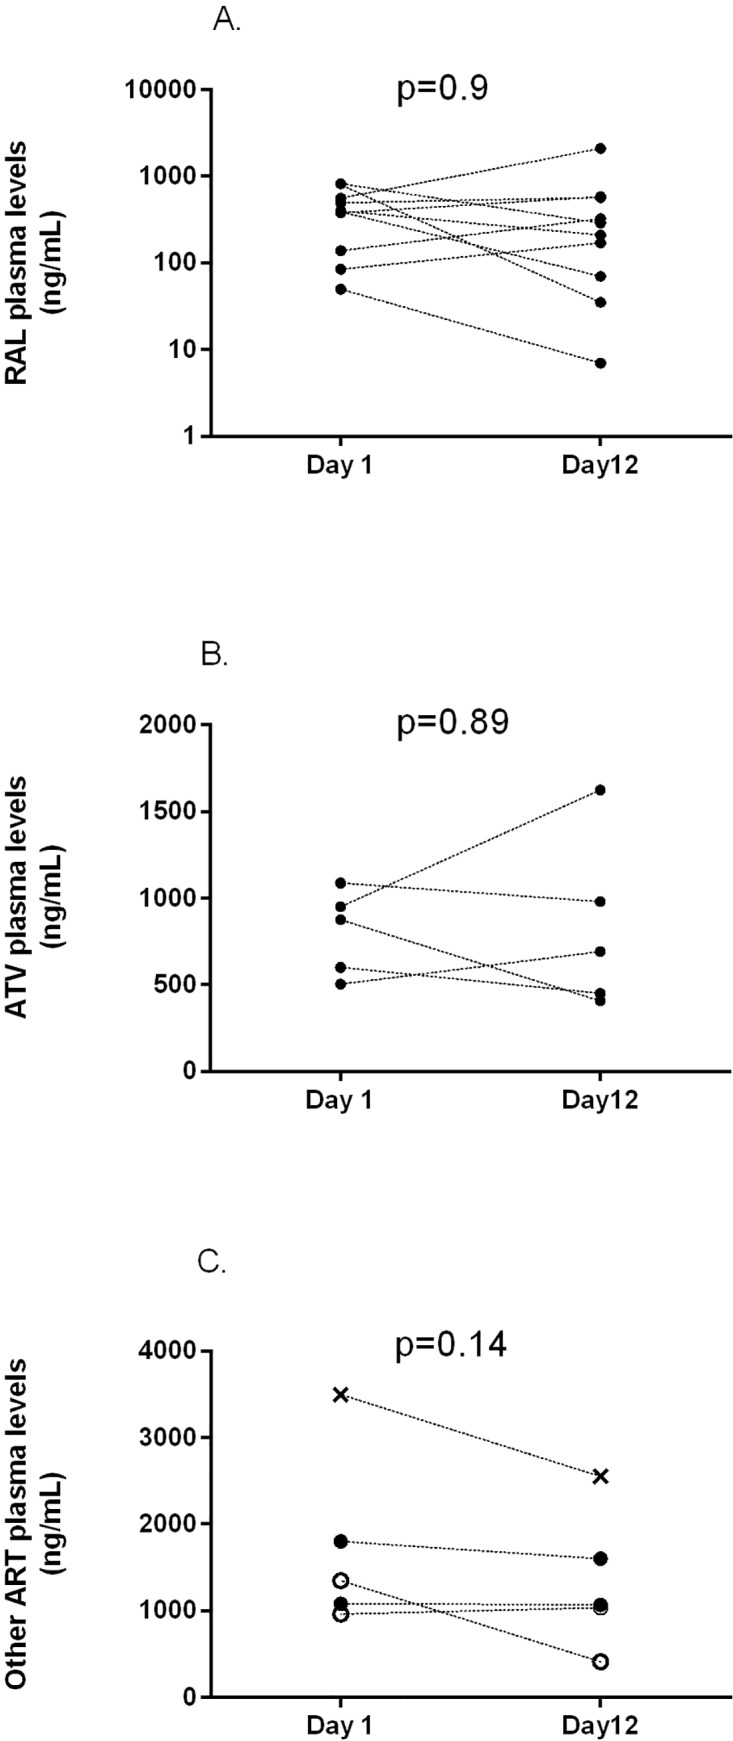
Plasma trough concentrations in patients before (day 1) and during (day 12) silibinin treatment.
A Raltegravir levels (n = 10) B Atazanavir plasma levels (n = 5) C x—-x Efavirenz (n = 1) ●—- ● Darunavir (n = 2) ○—-○Etravirine (n = 2).